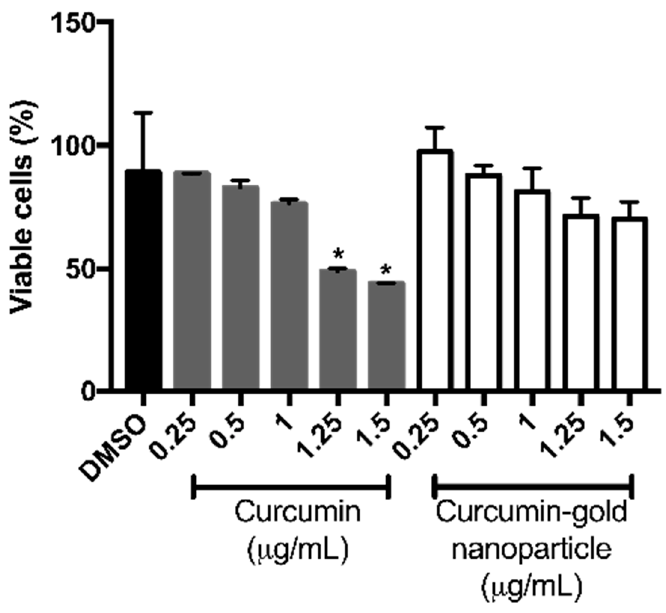
Figure 9. The viability of NIH/3T3 cells treated with curcumin and curcumin-gold nanoparticles at various concentrations. * p ≤ 0.05.